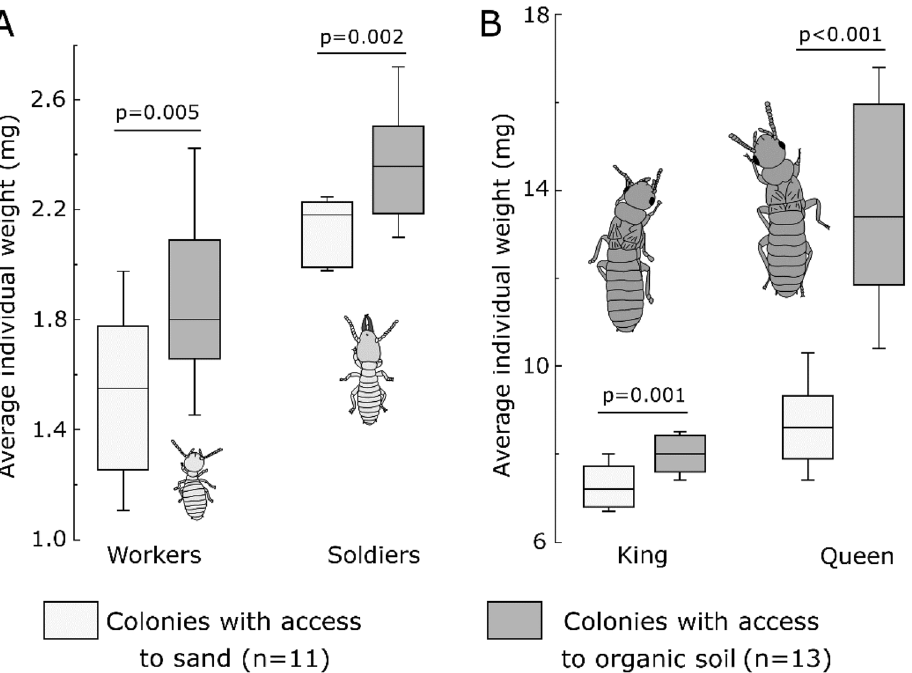
Figure 3. Boxplot distribution of individual caste weights (wet weight, mg) for 20 month-old colonies, after 6 months of soil treatment (sand vs. organic soil). ( A ) Workers and soldiers. ( B ) King and queen. All castes were significantly heavier in colonies reared on organic soil compared to colonies reared in sand ( t